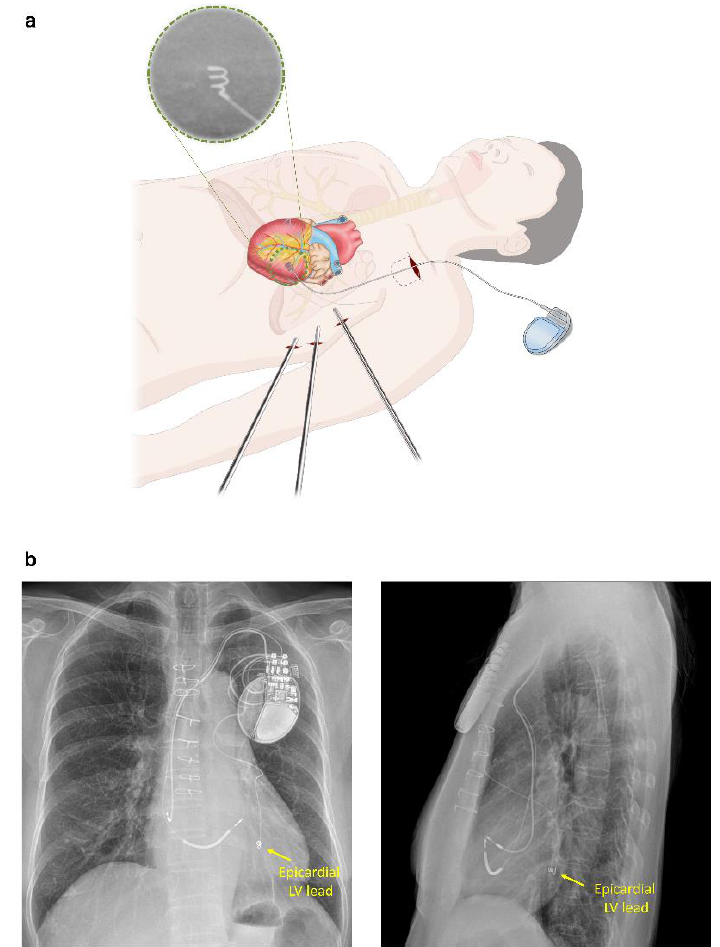
Figure 2. ( a ) Detailed illustration of epicardial LV lead implantation using the thoracoscopic approach; ( b ) post-operative chest X-ray showing an epicardial LV lead implanted into the LV lateral wall (Patient No.11). LV = left ventricle.